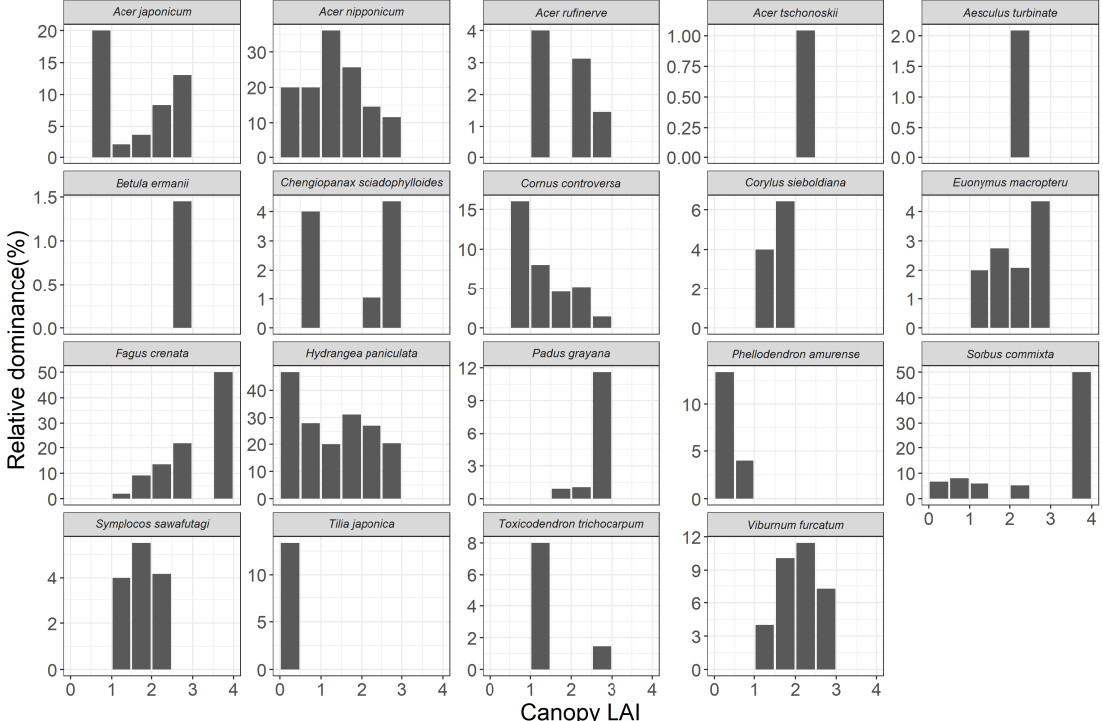
Figure 8. The relationship between the relative dominance of each species and canopy LAI in the subplots.